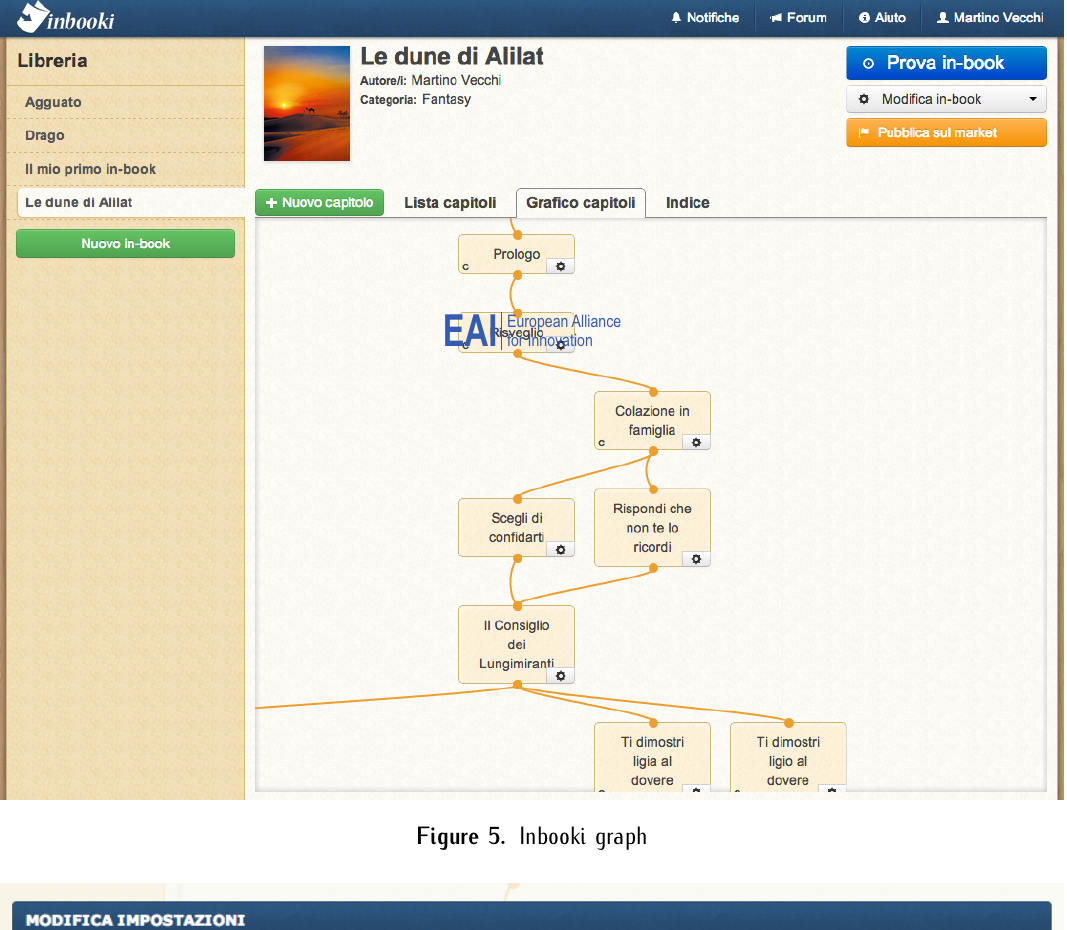
Figure 5. Inbooki graph